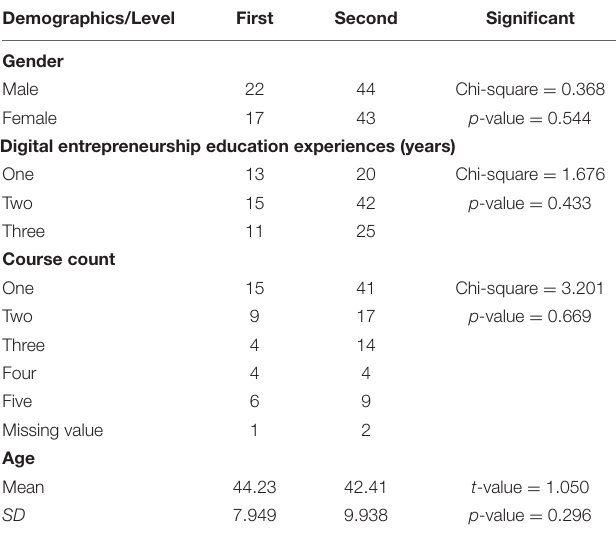
TABLE 1 | Profiles of participants ( N =